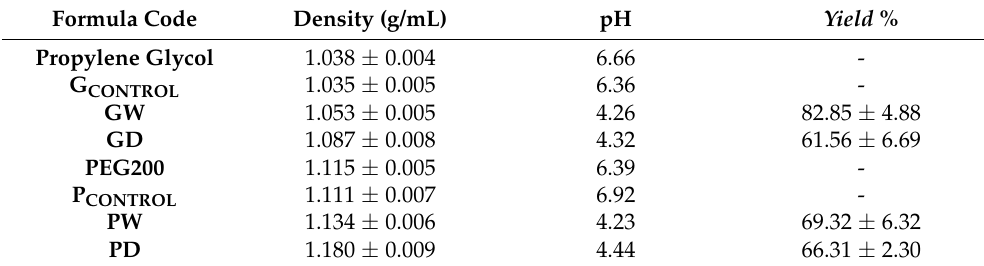
Table 2. Characteristics of the extracts in terms of density, pH and Yield % of the extraction process correlated to the respective pure solvents (propylene glycol and PEG200) used as references ( n =